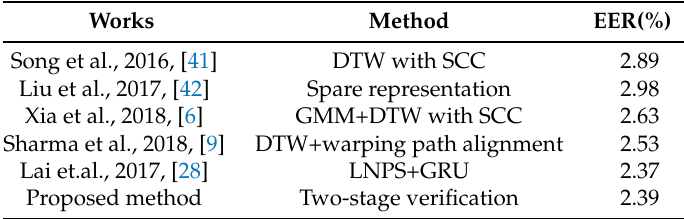
Table 6. Comparisons with the state-of-the-art works on database